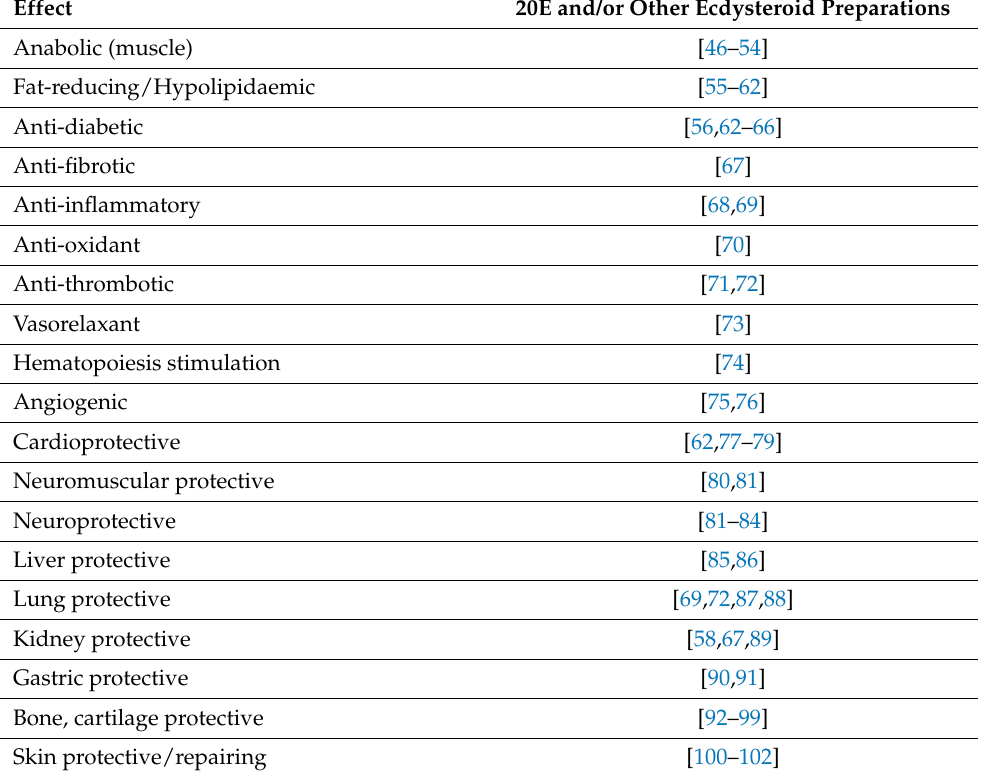
Table 2. Summary of the literature concerning 20E’s pharmacological effects in